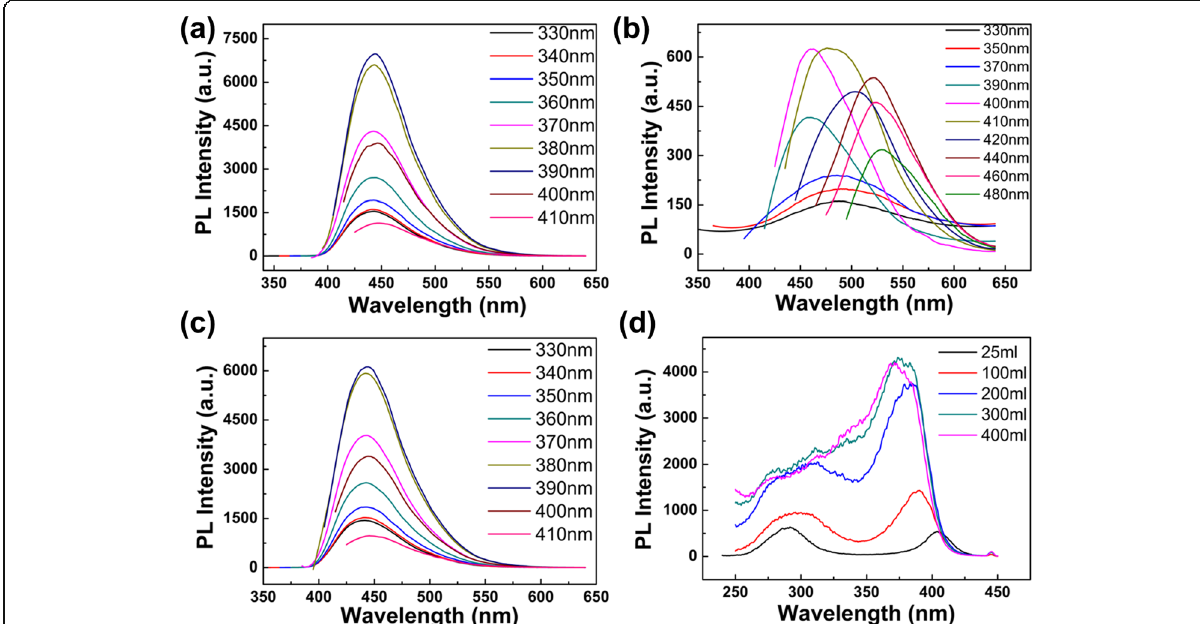
Fig. 4 Emission and excitation spectra of CDs in different volume of water and pH. a Emission spectra of CDs with 300 ml deionized water (pH 10.41). b Emission spectra of CDs with 5 ml deionized water (pH 12.08). c Emission spectra of CDs with 300 ml deionized water (pH 12.08). d Excitation spectra of CDs at 445 nm in different volume of